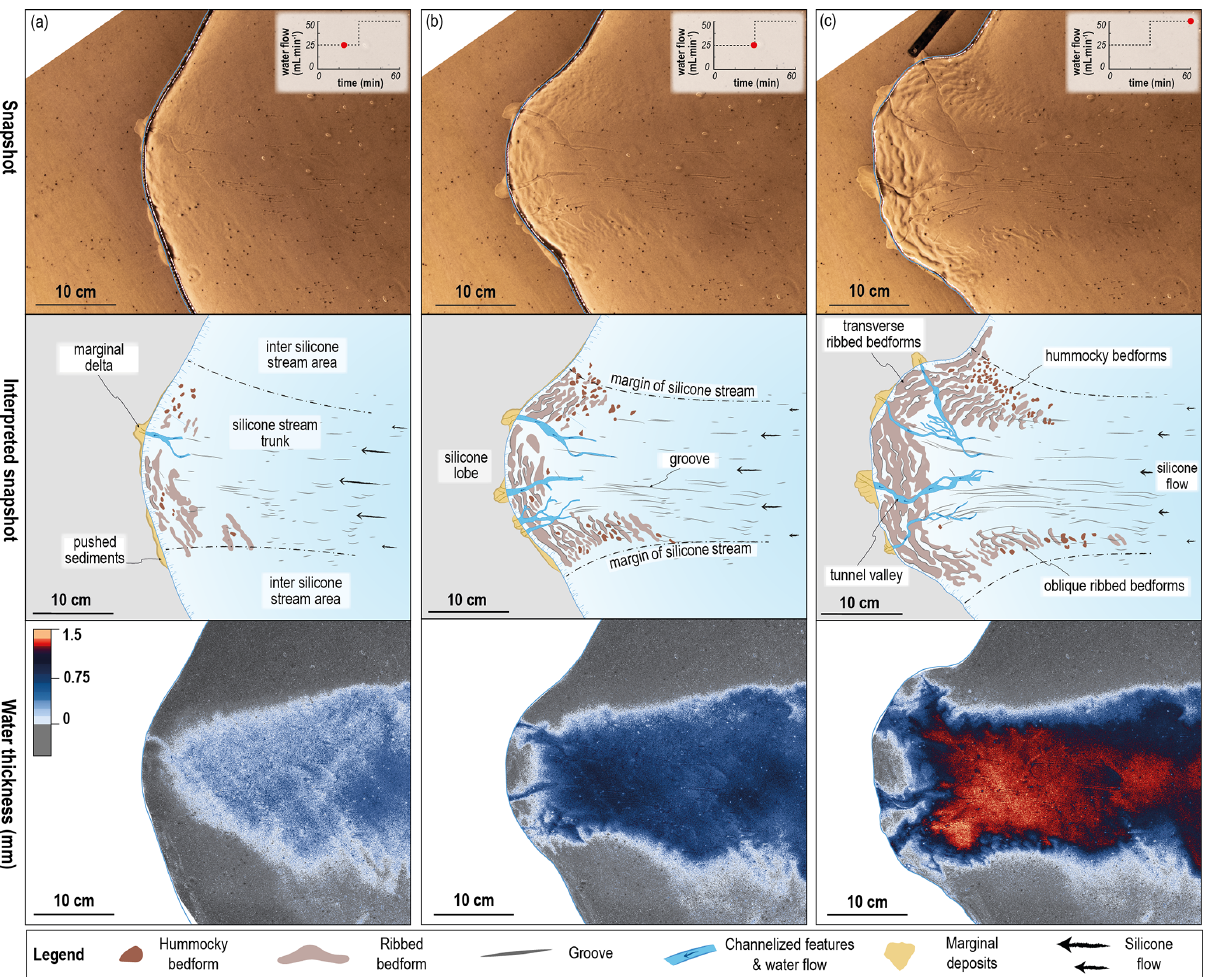
Figure 6. Temporal evolution (stages a, b and c) of the silicone stream and lobe system, for a typical experiment with a well-developed channelized drainage system (Experiment 10), illustrated with snapshots representative of the three main stages of development. The upper, intermediate and lower panels show, respectively, (i) white-light photographs of the surface of the model, (ii) interpretations of bedforms observed on the photographs and (iii) thickness (in mm) of the water film flowing beneath the silicone cap, derived from UV